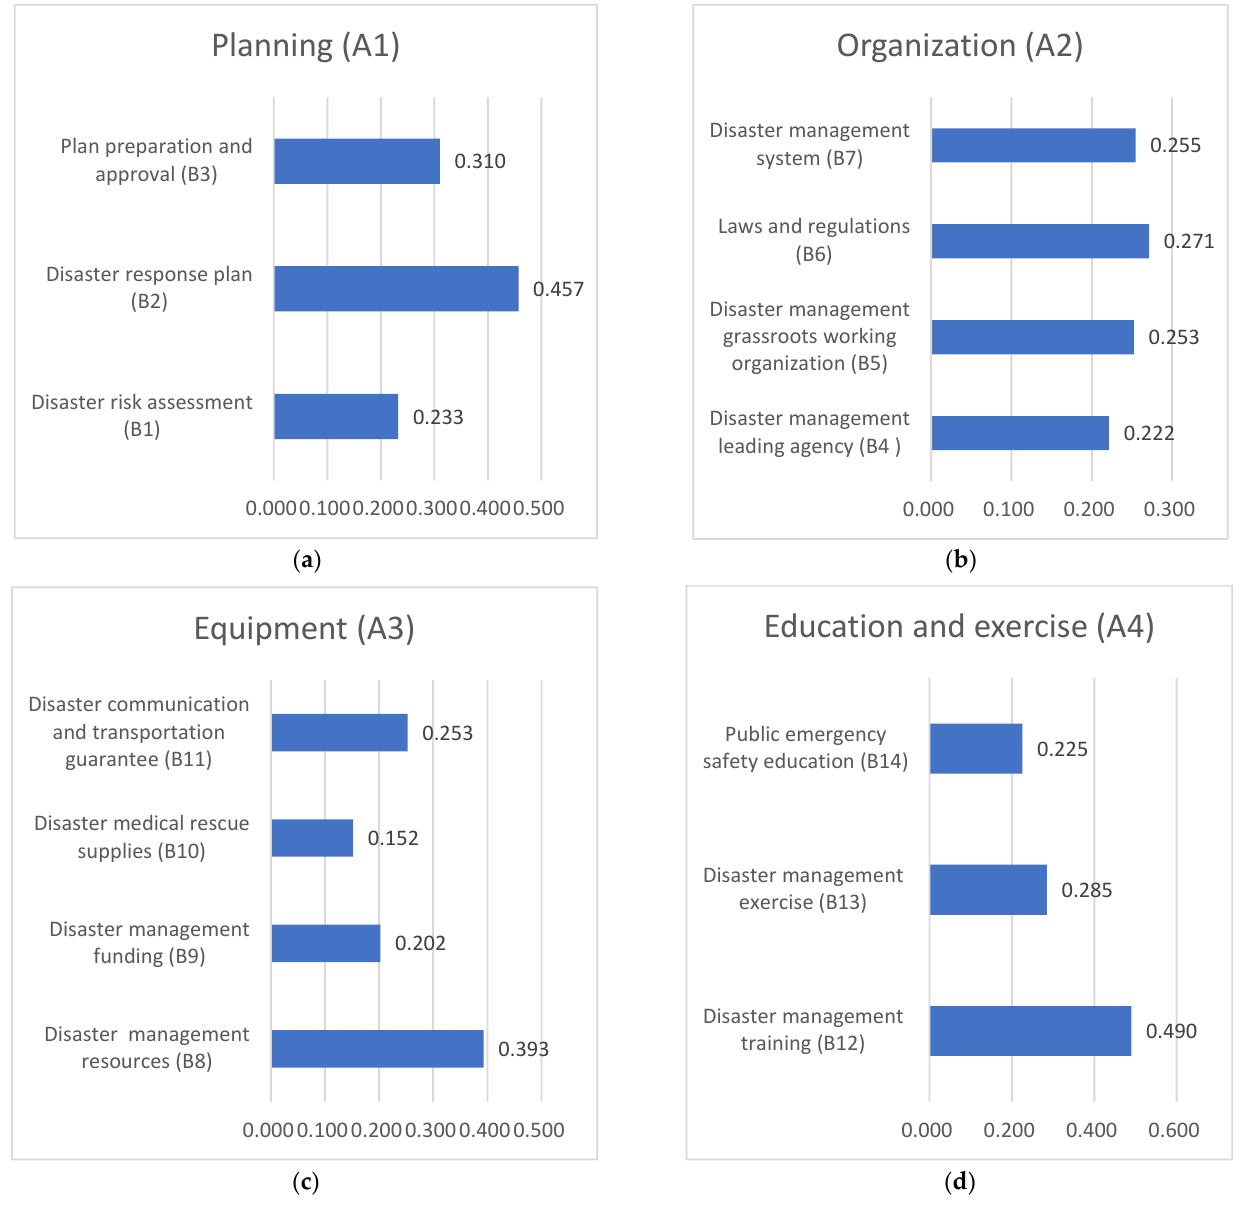
Figure 4. ( a ) The weight ranking of the third level (B1~B3) to the second level A1. ( b ) The weight ranking of the third level (B4~B7) to the second level A2. ( c ) The weight ranking of the third level (B8~B11) to the second level A3. ( d ) The weight ranking of the third level (B12~B14) to the second level A4.